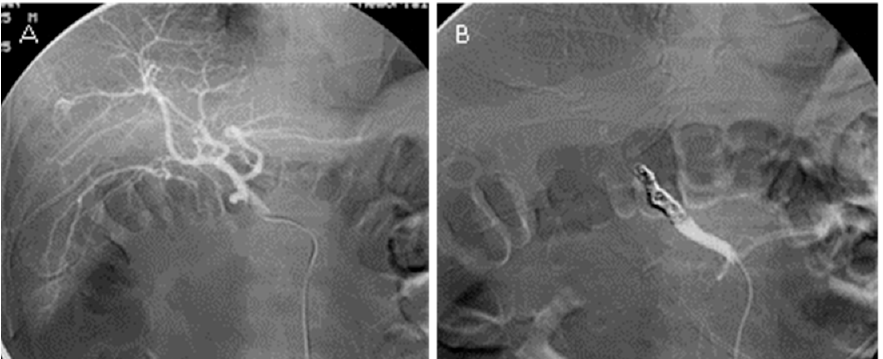
Figure 4. ( A ) Angiography image showing a pseudoaneurysm in the GDA stump without contrast extravasation. ( B ) Angiography after hepatic artery sacrifice, showing no opacify of the proper hepatic artery and GDA stump.